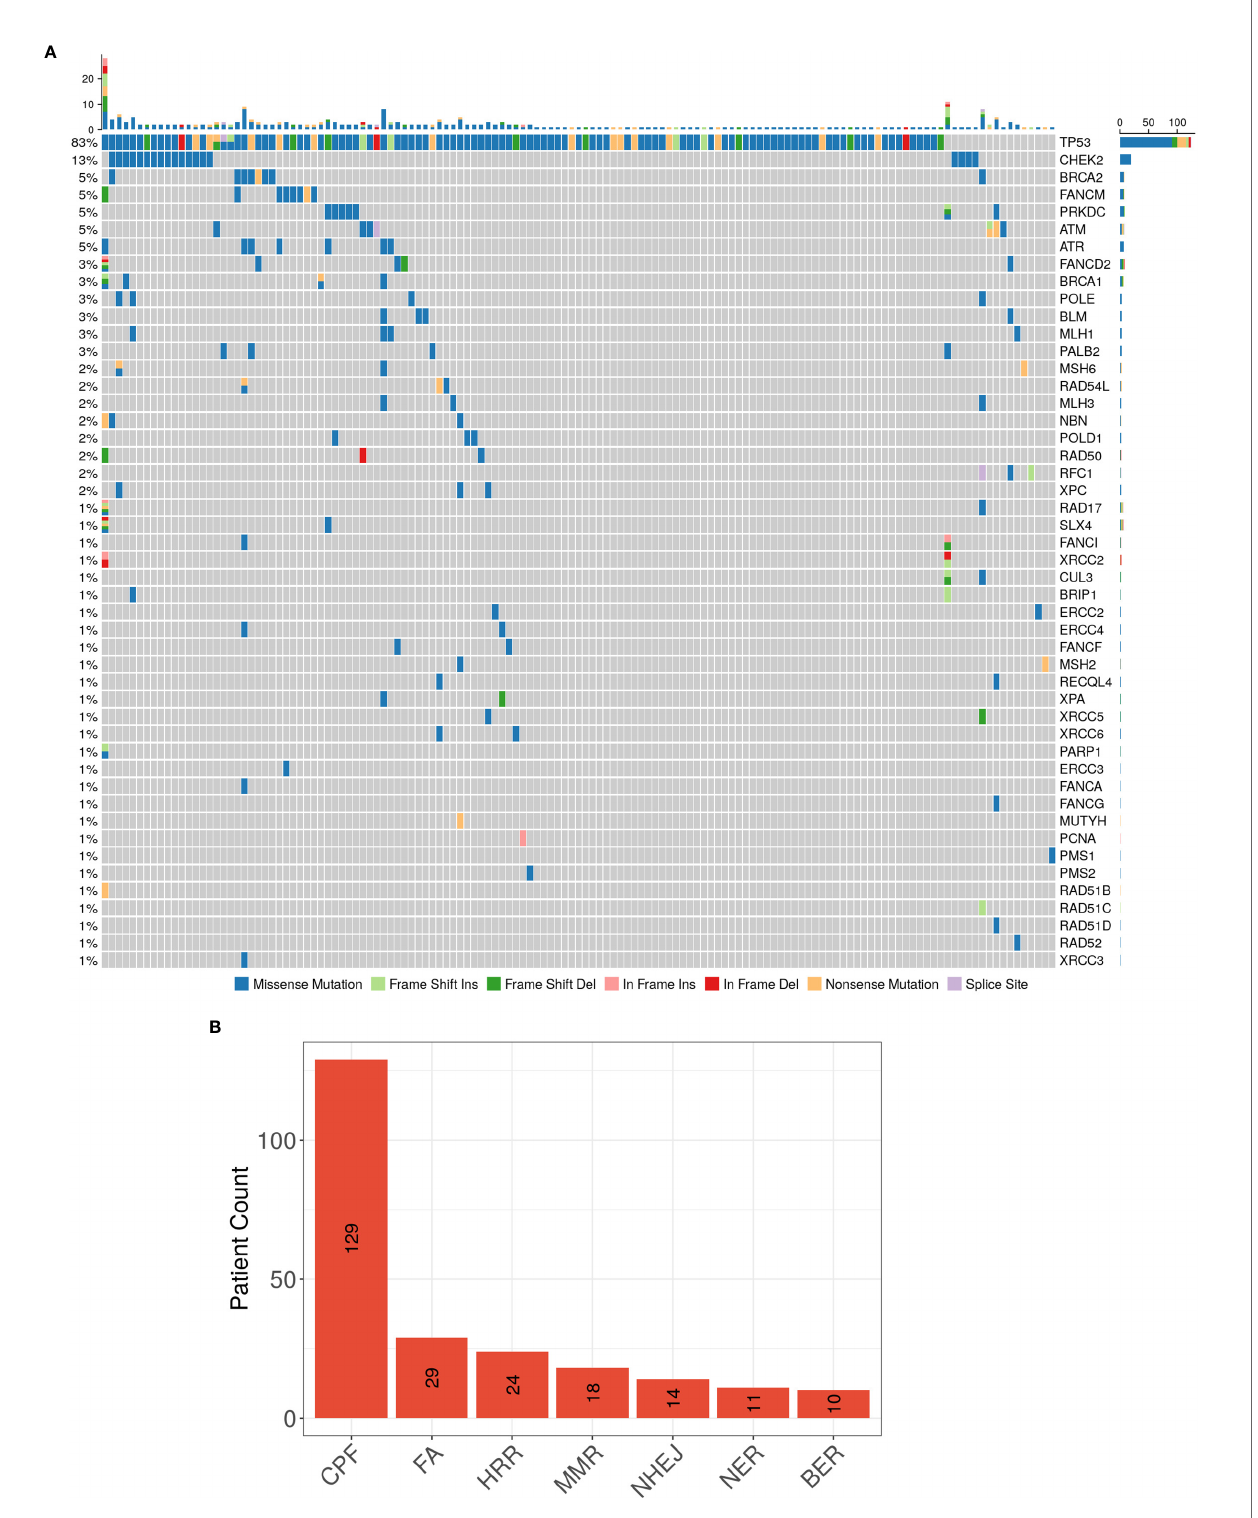
FIGURE 2 | (A) The spectrum of DDR genes with detected somatic mutations, and (B) the ranking of patients carrying mutations in the 7 DDR signaling pathways in our CRLM cohort NGS